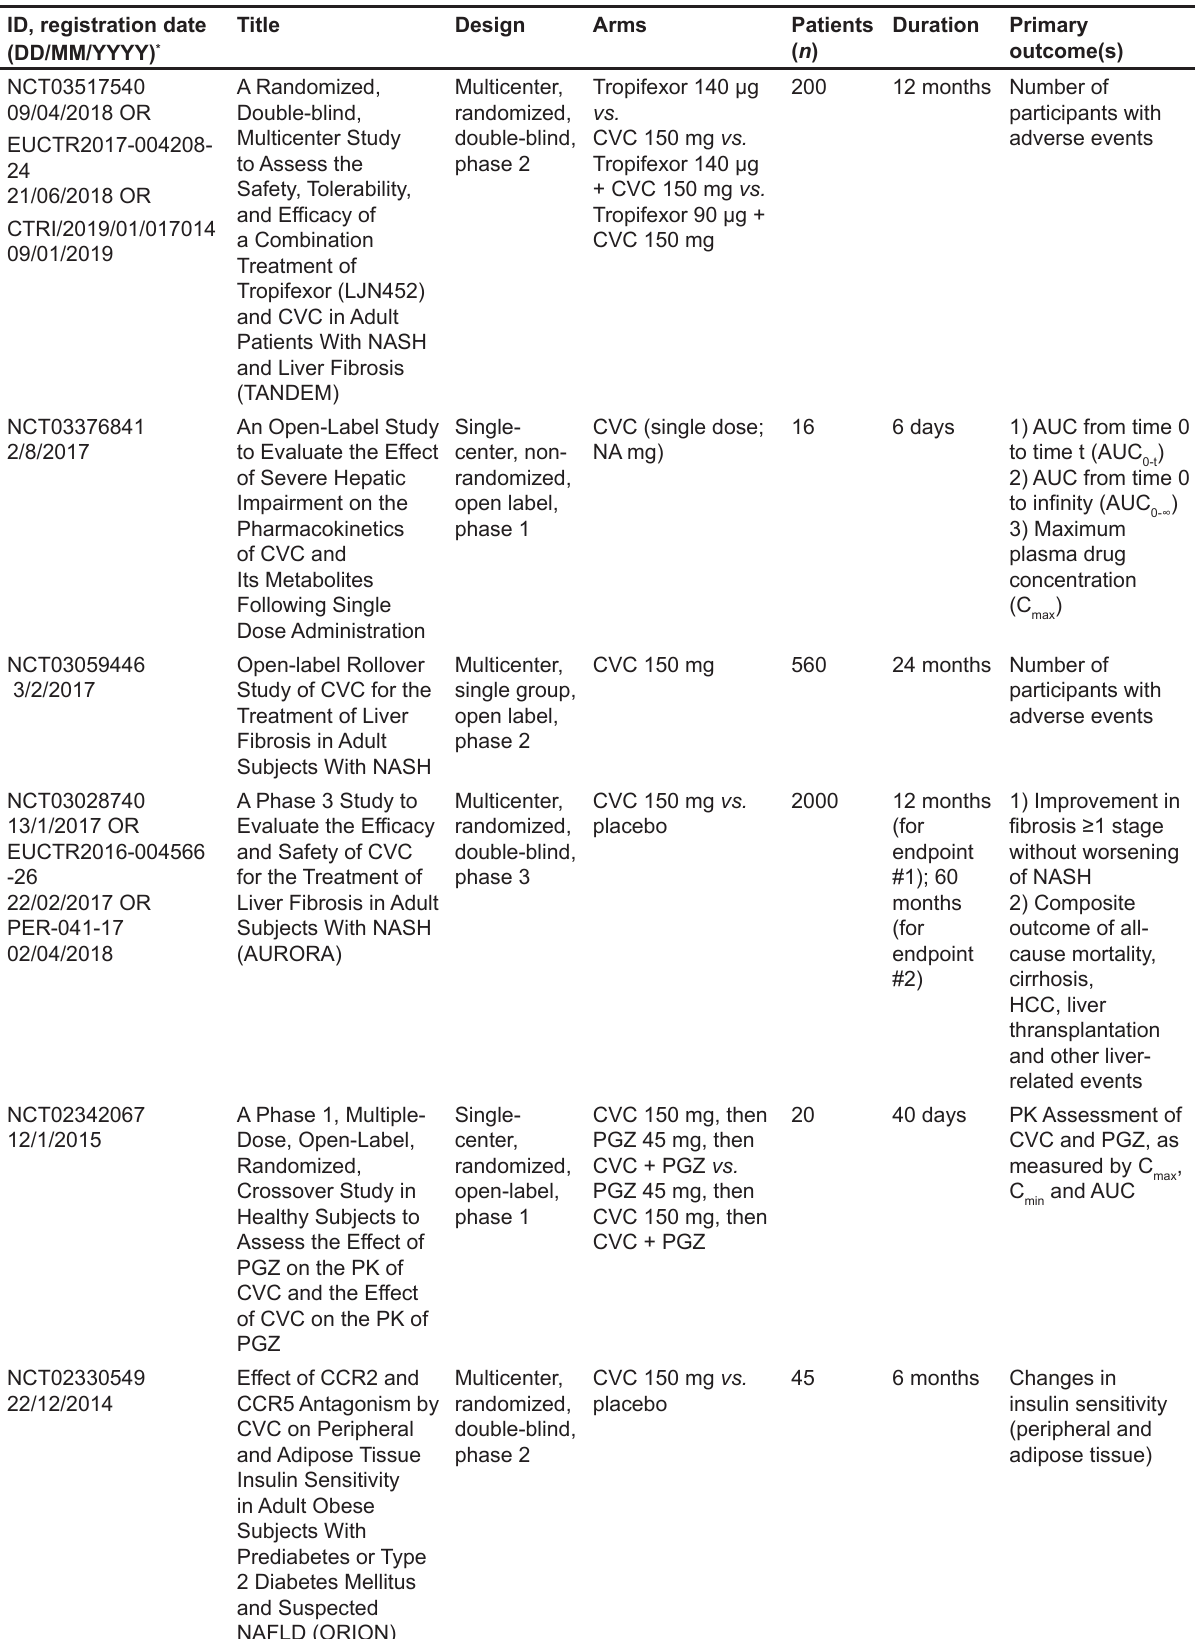
Table 1 . Registered ongoing clinical trials on CVC in patients with